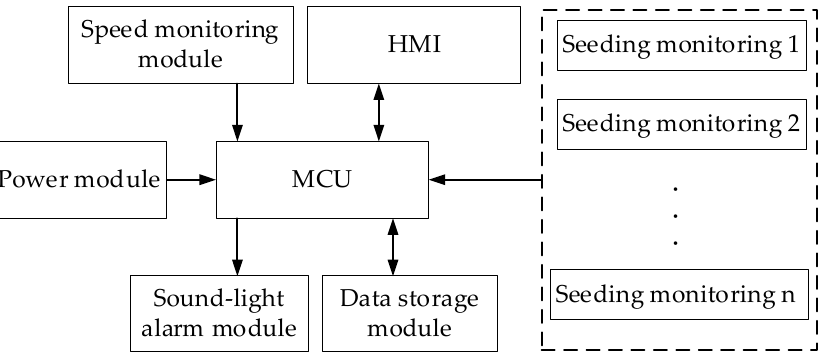
Figure 1. Structure diagram of the monitoring system of the seeder.